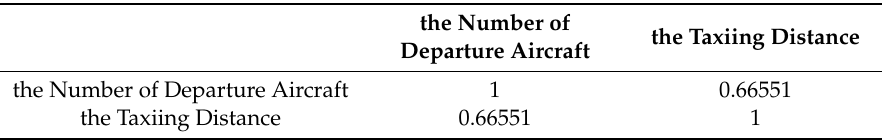
Table 2. Correlation